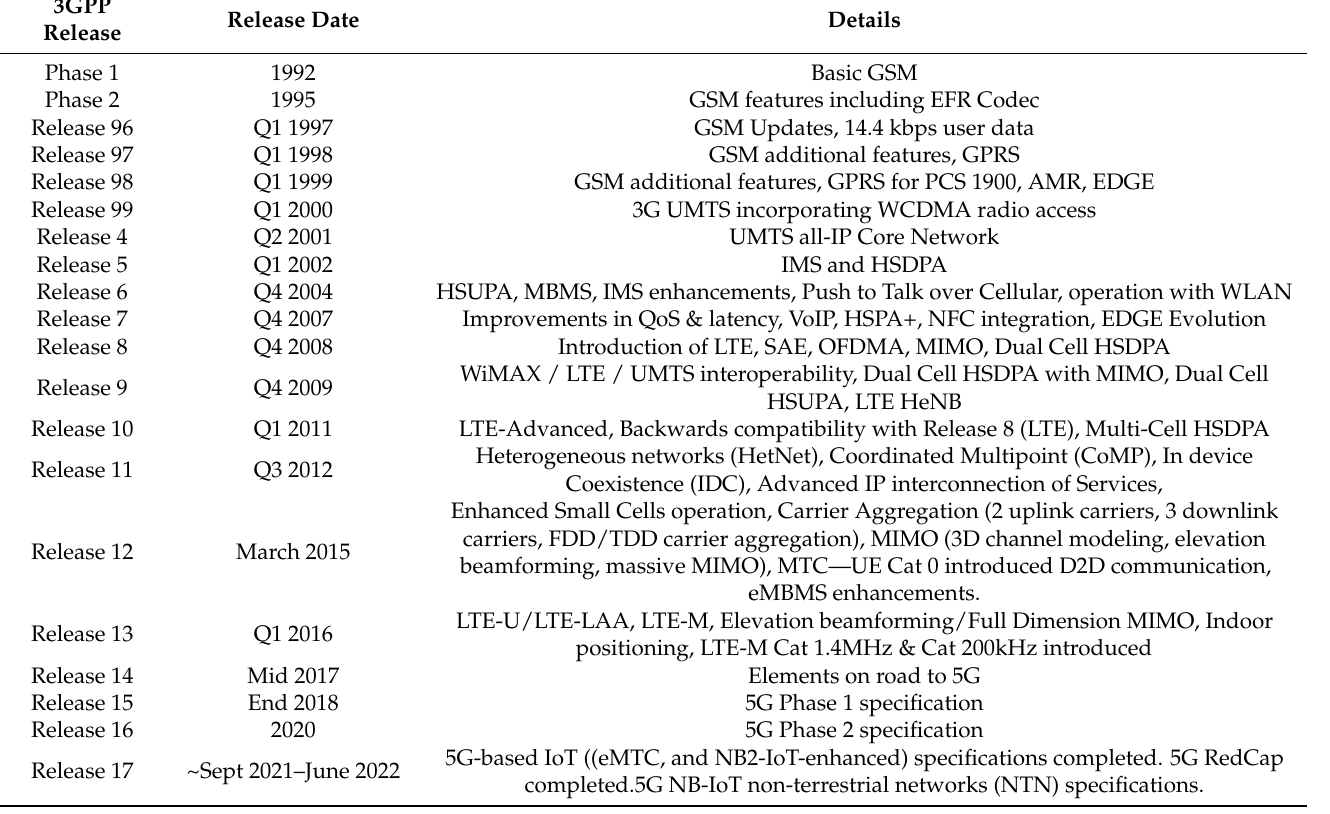
Table 3. 3GPP Release numbers and